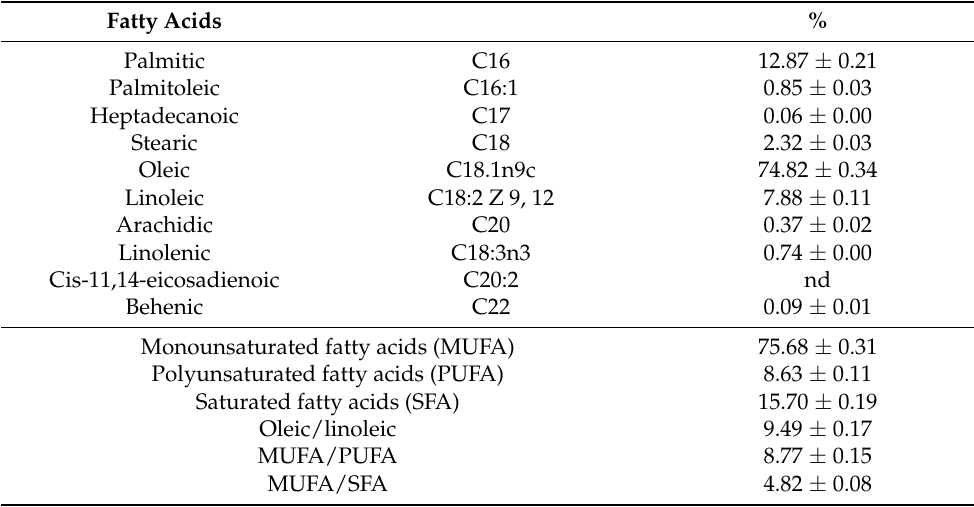
Table 4. Fatty acid composition of olive oil of cultivar “Oliva Bianca”. The parameters are reported as means ± SD of three different replicates ( n = 3).